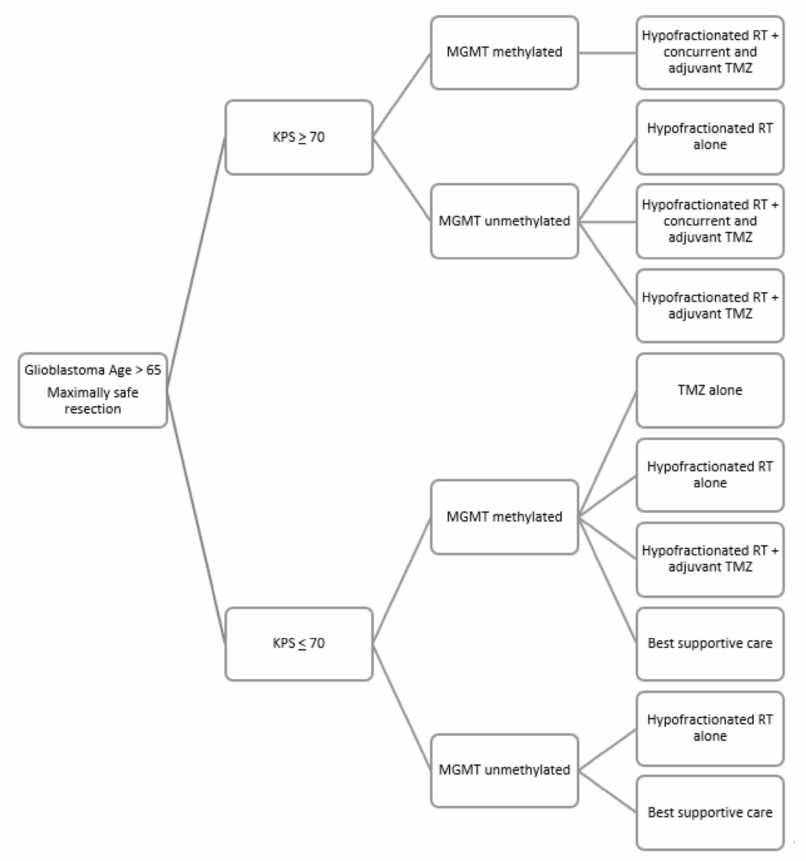
Figure 1. Proposed algorithm of post- operative management of elderly glioblastoma. Leg- end: KPS = Karnofsky Performance Status; MGMT = O6-methylguanine-DNA-methyltransferase; RT = radiotherapy; TMZ =